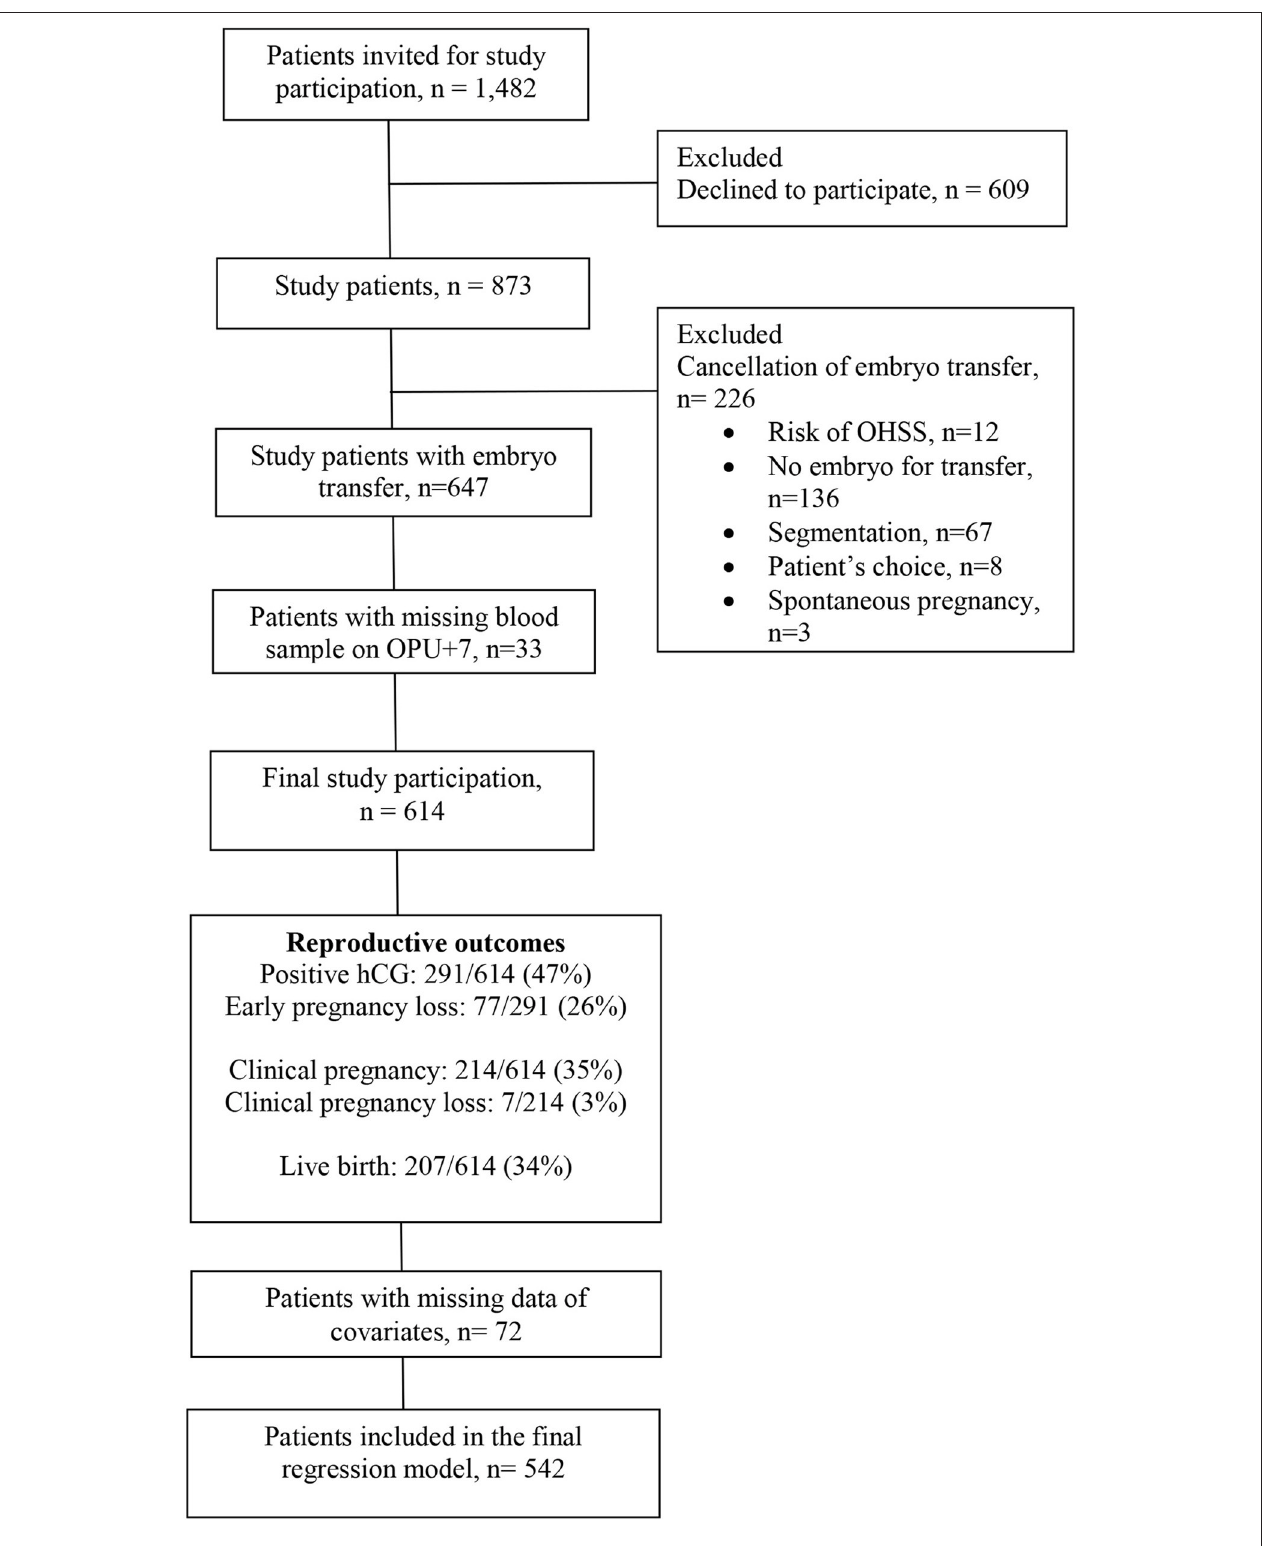
FIGURE 1 | Flowchart of study participation.